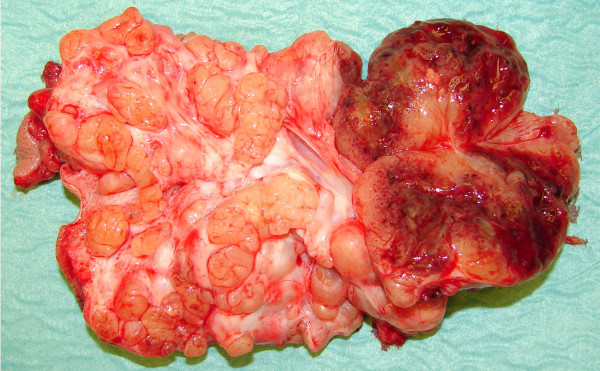
Macroscopic appearance this scrotal ancient schwannoma. A white multinodular tumour with haemorrhagic areas.